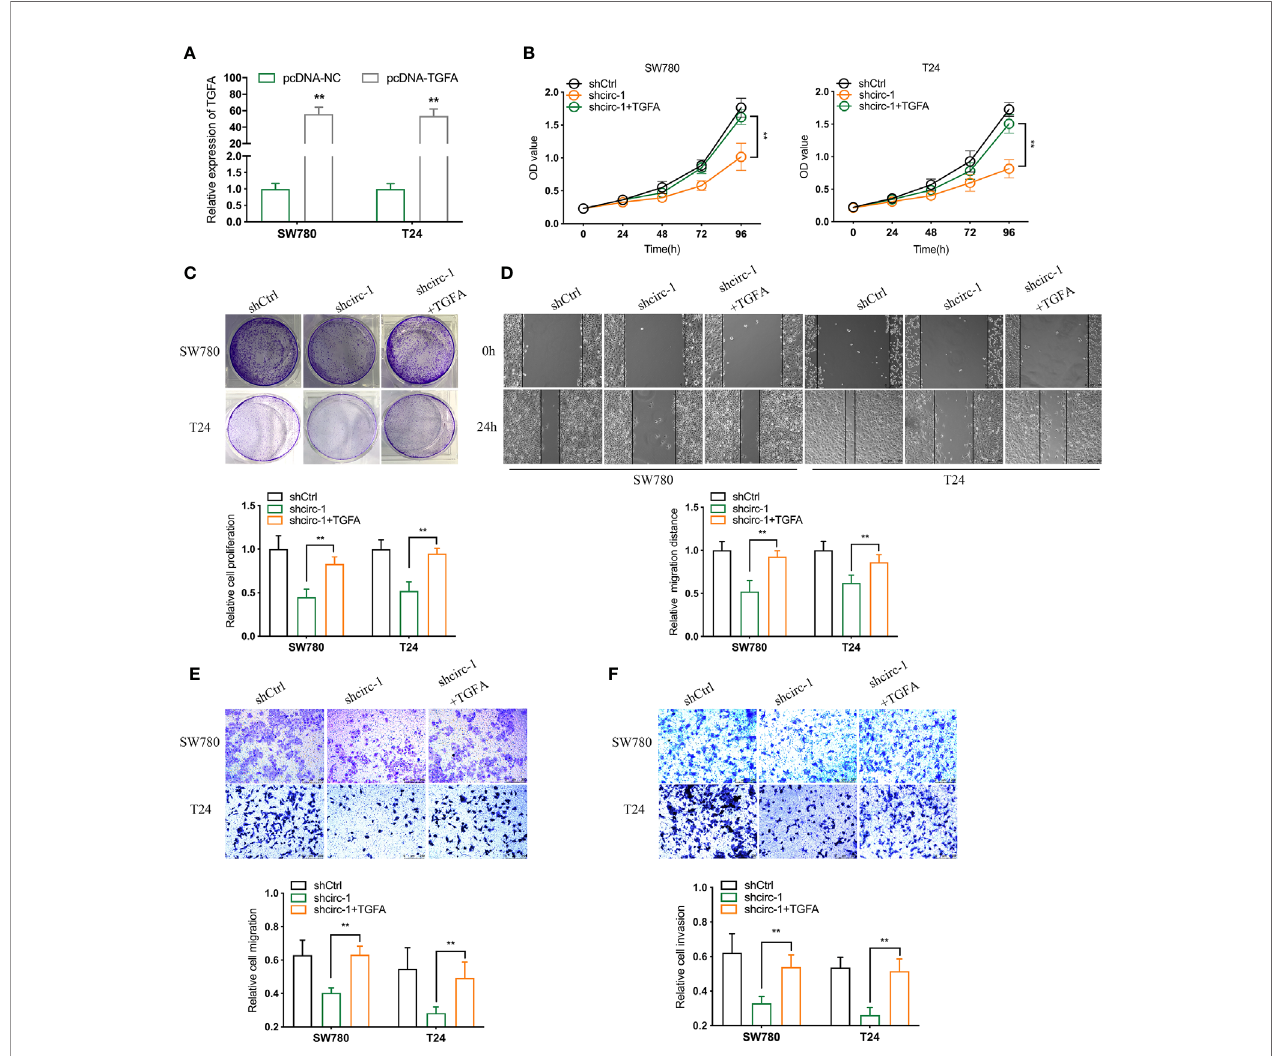
FIGURE 6 | Overexpression of TGFAreverses the decline in BCa cellgrowth andmetastasis in vitro induced bycircTAF4B knockdown. (A) The effectof pcDNA3.1-TGFA was veri fi ed byqRT-PCR. (B, C) CCK-8 and colonyformation assaysshowedthat TGFAenhanced the reduction incell proliferation causedby shcircTAF4B. (D,E) Wound healingand Transwellmigration assaysshowed that TGFA reversedthe cell migration reduction inducedby shcircTAF4B. (F) Transwellinvasion assays showed that TGFA reversed the inhibition of cell migration mediated byshcircTAF4B. Data represent the mean ± SDof more than three independent experiments. *p < 0.05; **p <